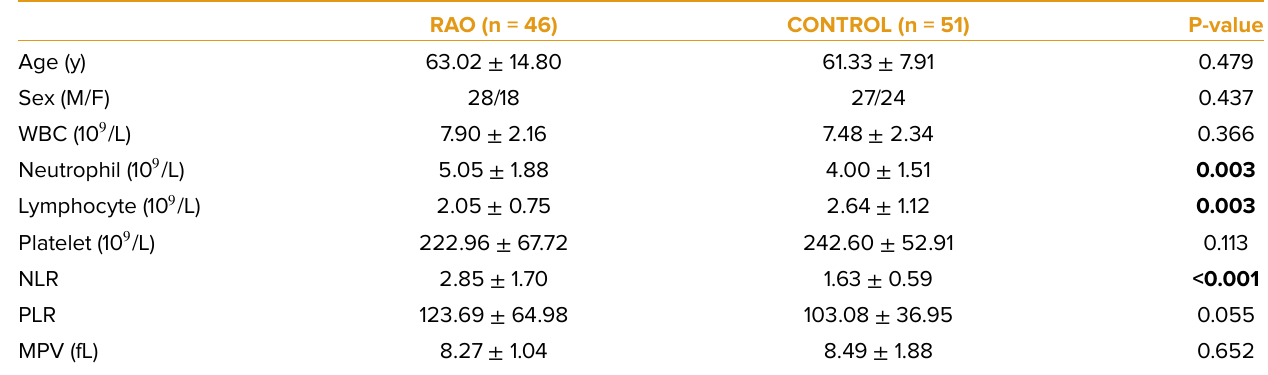
Table 1. Demographic features and laboratory findings in the RAO and control groups